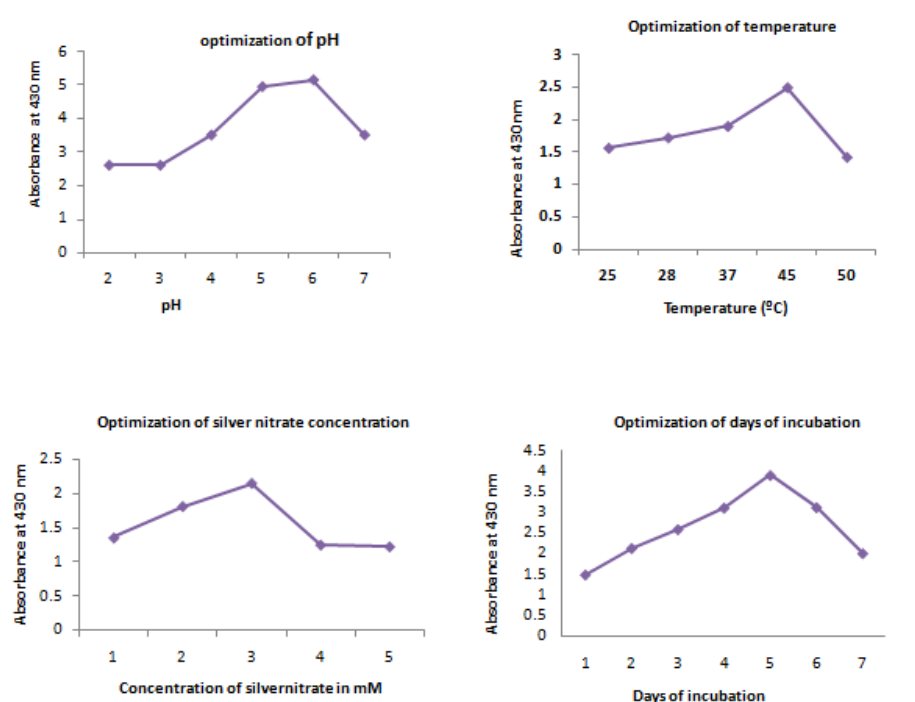
Fig. 9. Optimization of physical parameters pH, temperature, Concentration of silver nitrate and days of incubation for biosynthesis of silver nanoparticles.